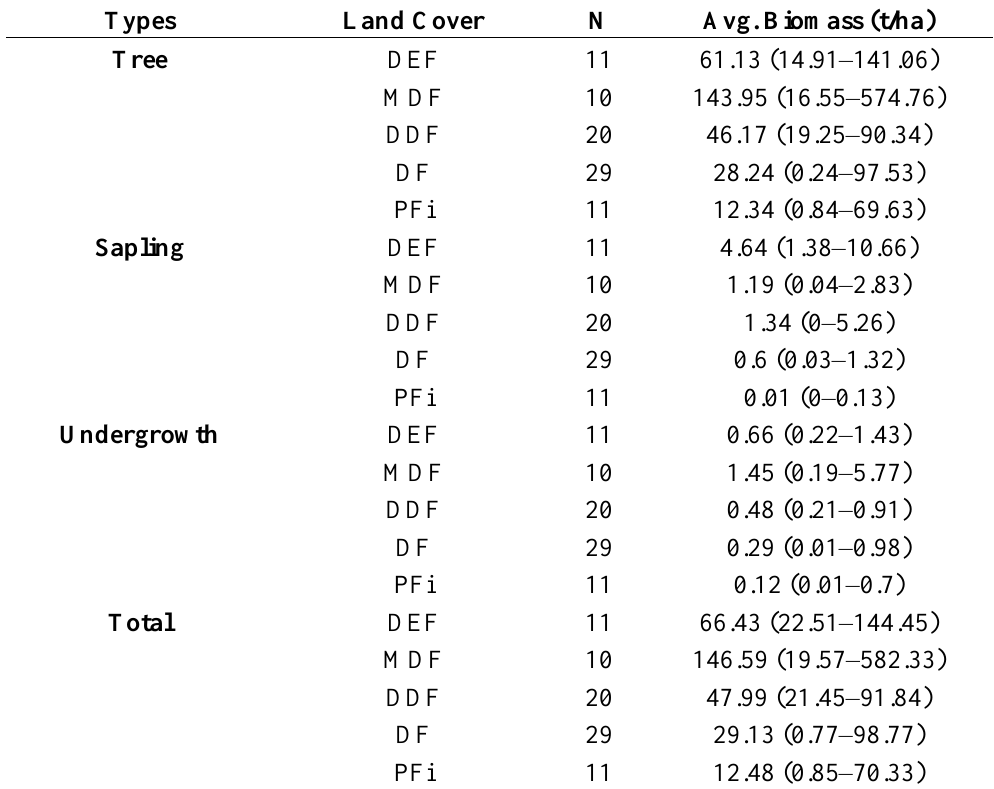
Table 5. The total biomass of trees, saplings, and undergrowth by vegetation